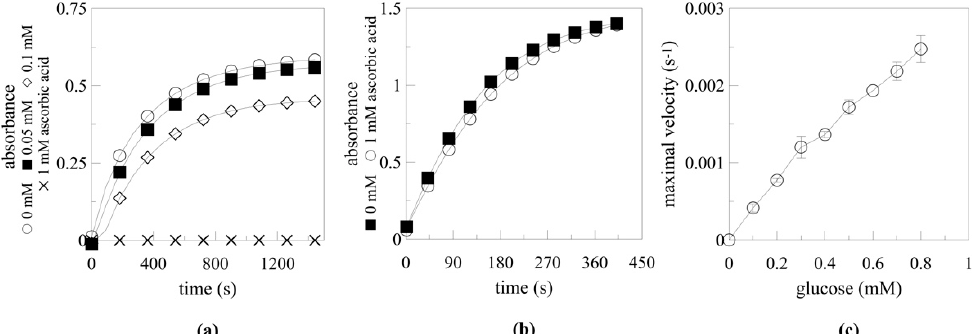
Figure 2. The effect of ascorbic acid on glucose determination assays. Inhibition of the colour development of glucose oxidase (GOD) kit by ascorbic acid ( a ). Ascorbic acid-independent glucose dehydrogenase (GDH) activity ( b ) and the dependence of maximal velocity in GDH catalysed reactions with various glucose concentrations ( c